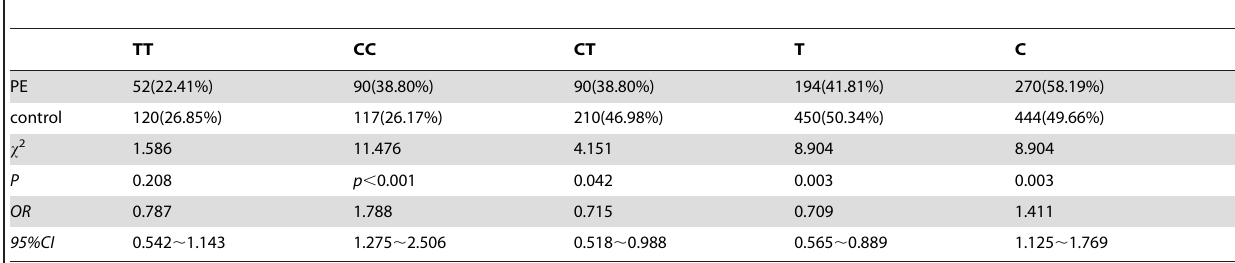
Table 2. Distribution the allele frequency and PE susceptibility of the IL-1 b -31C/T polymorphism between case and control